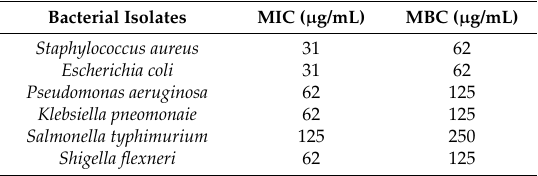
Table 1. MIC and MBC values of biosynthesized AgNPs against bacterial